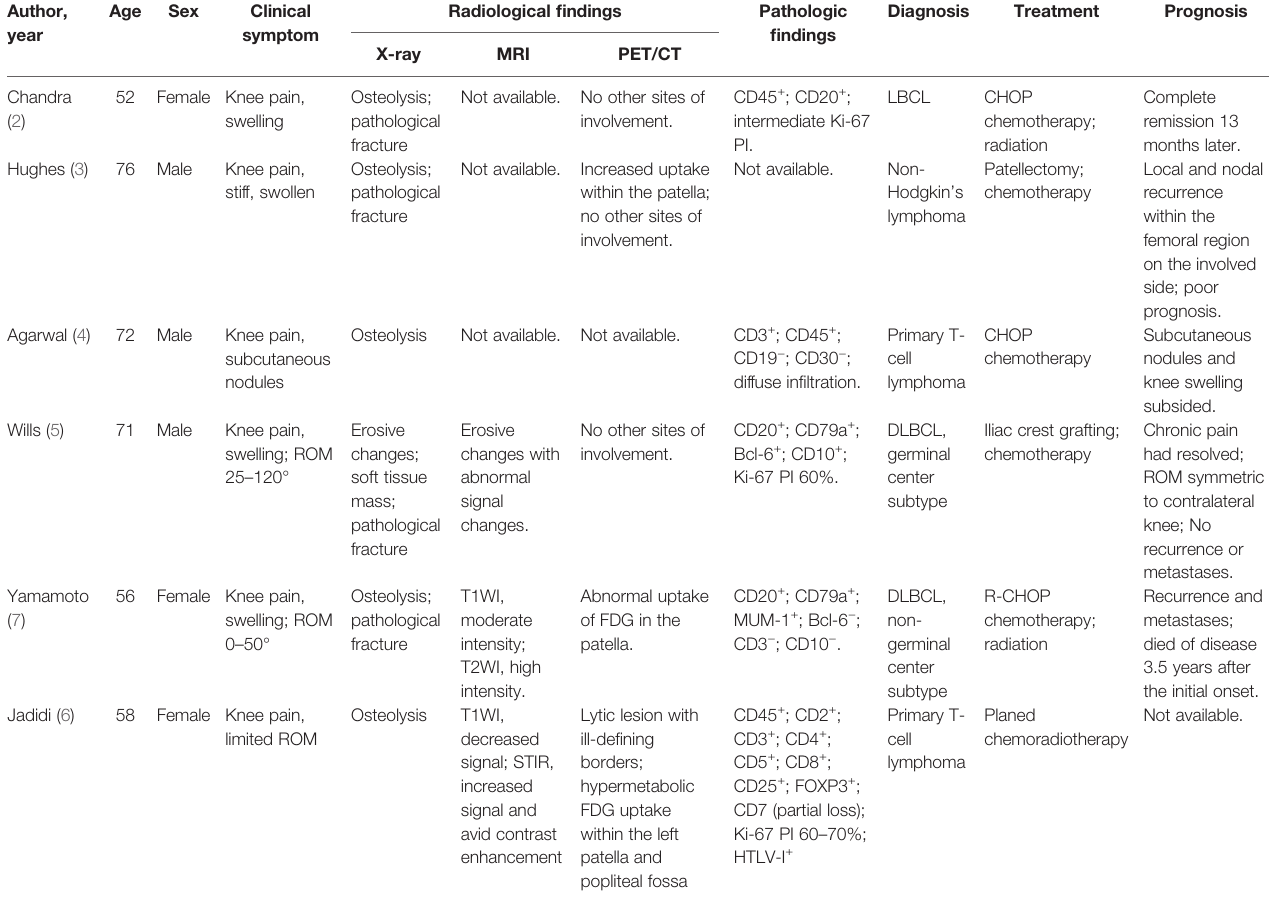
TABLE 1 | Details of the reported primary bone lymphoma of